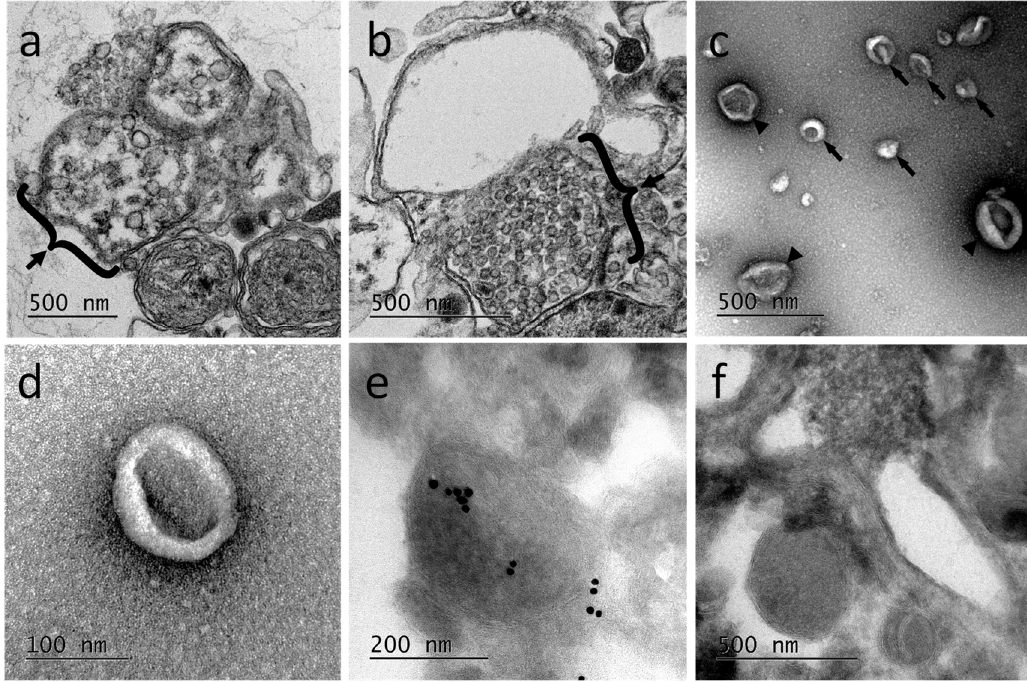
Figure 4. Transmission electron microcopy (TEM) of leech microglial EVs. ( a , b ) Cryosections of isolated microglia containing into the cytoplasm multivesicular bodies (braces), structures typical of exosome biogenesis. ( c , d ) Morphological analyses of microglia-released extracellular vesicles collected by differential centrifugation of primary microglia conditioned medium. These EV-enriched fractions revealed the presence of vesicles from 50 nm (arrows) to 300 nm (arrowheads) in diameter ( c ), most of which are around 100 nm ( d ). Immuno-gold labeling performed on cryosections from the extracellular vesicles (EV)-enriched samples showed the presence of some EVs positive to primary anti-human Alix antibodies ( e ). Negative controls were performed incubating EV sections with secondary antibodies alone ( f ).